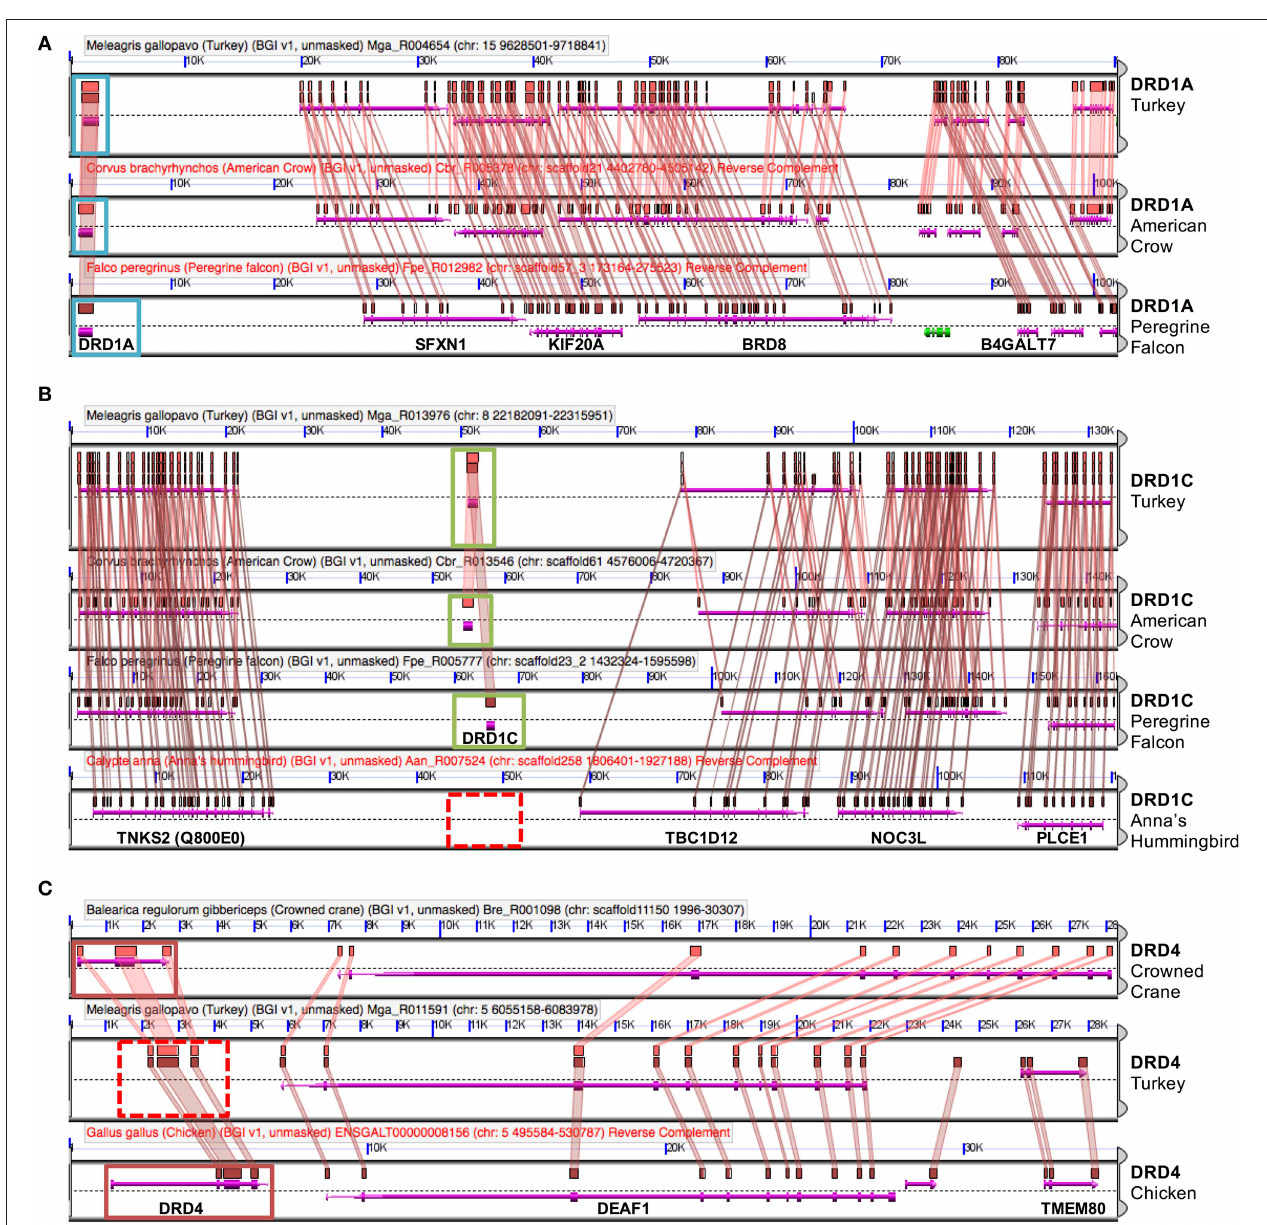
FIGURE 3 | Dopamine receptor identification by synteny. Genes were confirmed via microsynteny analysis with known genes from Turkey or Chicken. Each comparison consists of genomic panels with the dashed line separating top and bottom strands of DNA. Gene models are represented by colored arrows above and below that dashed line, with gene symbols annotated on the bottom panel. Colored boxes drawn above gene models with lines connecting them between two genomic regions denote pair-wise regions of sequence similarity. Genes overlapped by regions of sequence similarity are colored purple; a colinear pattern of these genes is used to infer synteny. Analyses identified three situations: (A) Example of DRD1A confirmation, in American Crow and Peregrine Falcon. Confirmed genes are boxed in light blue. Note intact gene model (purple arrow), sequence similarity of genes, as well as collinear order of genes on surrounding genomic region. (B) Example of a missing gene (DRD1D), in Anna’s Hummingbird. Syntenic genomic regions containing DRD1D are boxed in green and putatively absent DRD1D are indicated by a dashed red box. Note that there is no sequence similarity between syntenic regions where the gene should be present in hummingbird. (C) Example of a likely present but unannotated gene (DRD4) in Turkey. Solid red boxes indicate two present genes, and the dashed red box indicates the area with a missing gene model. Note the high level of sequence similarity between syntenic regions overlapping the missing gene (colored boxes with connecting colored wedges). Analyses can be regenerated at: (A) http://genomevolution.org/r/e7sj (B ) http://genomevolution.org/r/e84r (C )